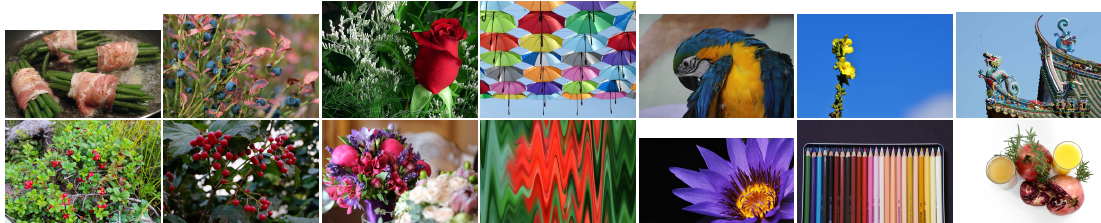
Figure 1. The image dataset used for testing. Highly saturated images from the web with dominant red–green and blue–yellow contrast. All images are available under the CC0